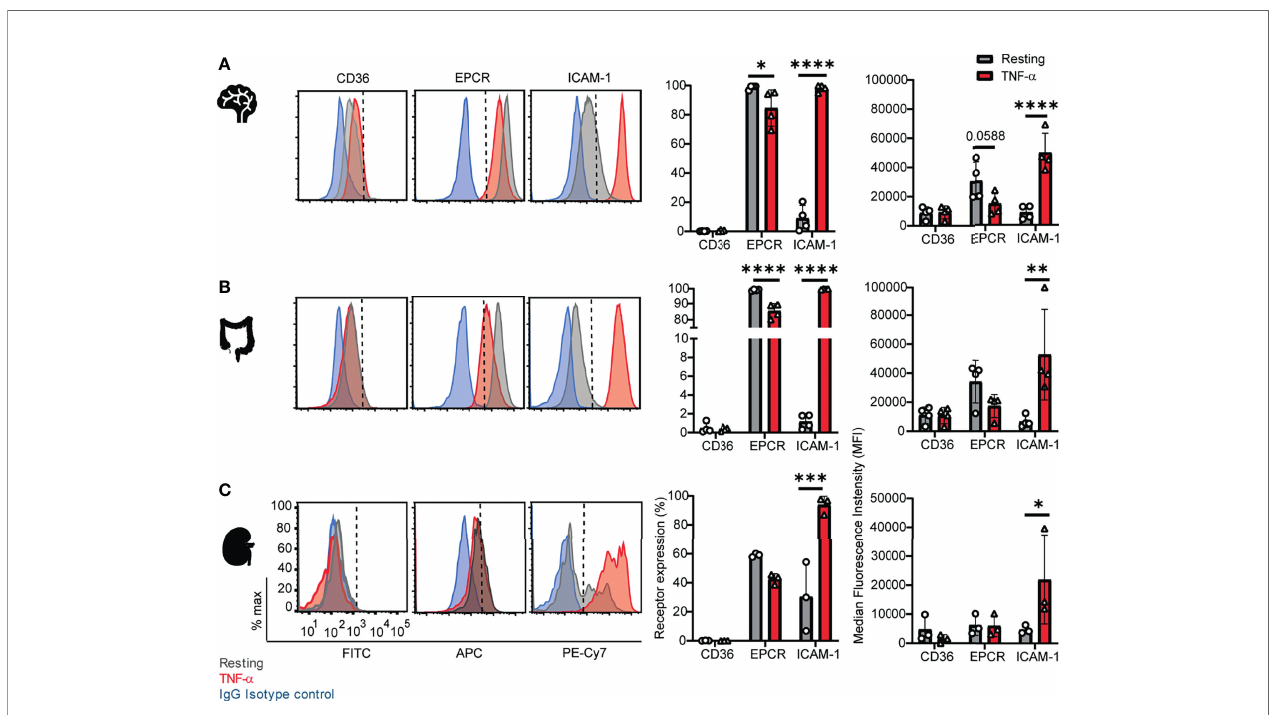
FIGURE 1 | Surface expression of CD36, EPCR, and ICAM-1 on primary human brain, intestinal and kidney endothelial cells. (A) Brain, (B) Intestinal, or (C) Peritubular kidney microvascular endothelial cells were stained for CD36, EPCR and ICAM-1 expression on resting or TNF- a -stimulated cells (20-24 hours treatment). Histograms show expression levels on live/CD31 + cells. The percentage of each receptor expression was determined by subtracting isotype control antibody from the target antibody levels. Positive is de fi ned as being above the vertical dashed line in the histogram. Data in bar graphs are expressed as mean ± SD and were analyzed by 2-way ANOVA, using Sidak ’ s multiple comparisons test. *p<0.05; **p<0.01; ***p<0.001; ****p<0.0001. Additional data is shown in Supplementary Figures 1, 2